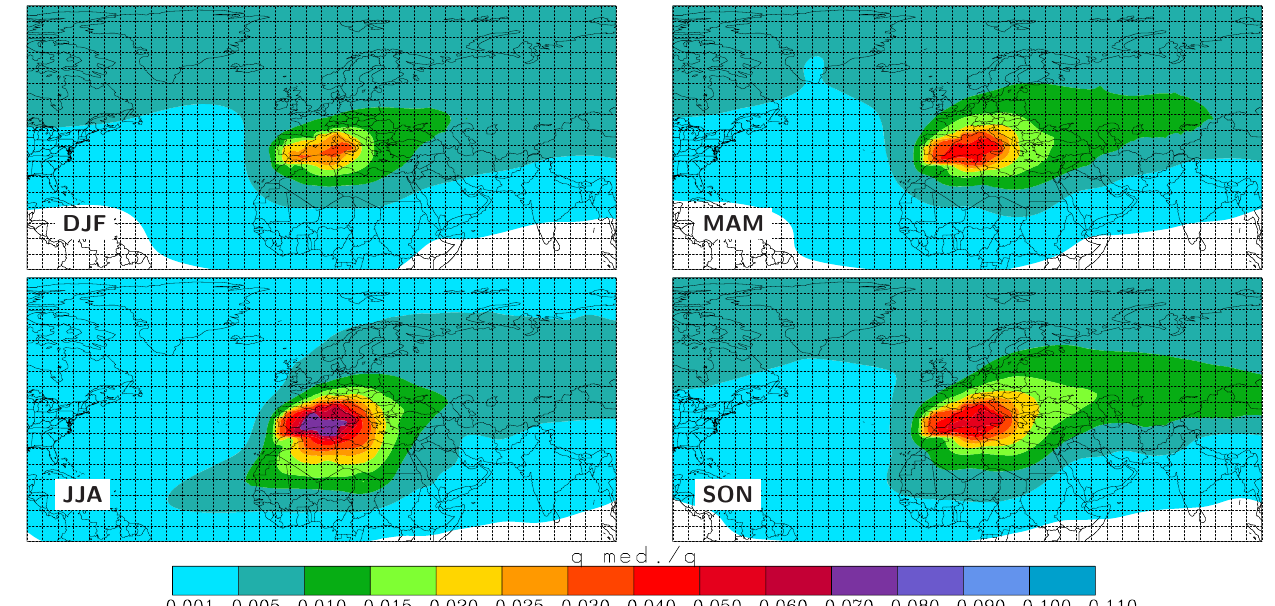
Fig. 7. Seasonal averages of the mixing ratio of the Mediterranean moisture to non-Mediterranean moisture for the Mediterranean basin as a whole.